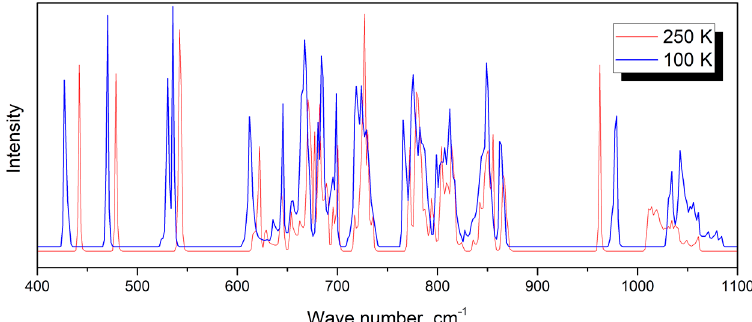
Figure 6. Comparison of the low- (blue) and high-temperature (red) phonon spectra at 100 and 250 K.